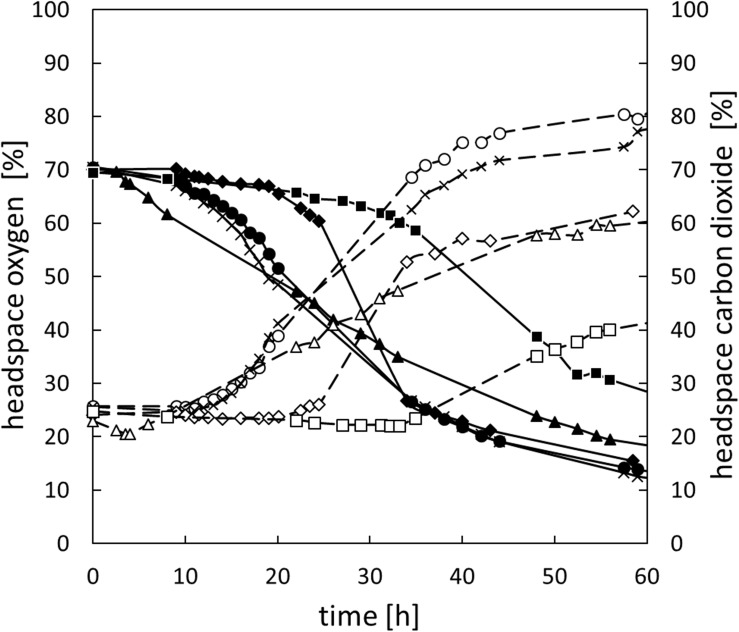
Change of the headspace gas composition for all species over 60 h. B. thermosphacta TMW2.2101 (◆), C. divergens TMW2.1577 (■), C. maltaromaticum TMW2.1581 (▲), L. gelidum subsp. gelidum TMW2.1618 (⚫), L. gelidum subsp. gasicomitatum TMW2.1619 (x). Solid line, black symbol: oxygen concentration. Dotted line, white symbol: carbon dioxide concentration. Values represent average values of three independent replicates.